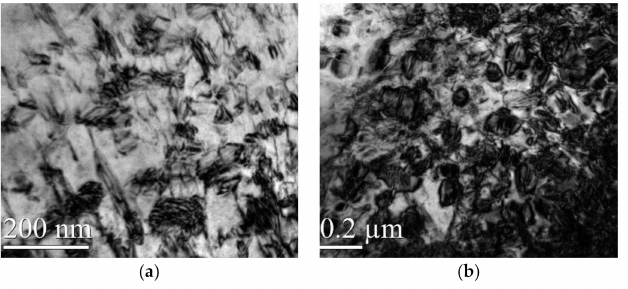
Figure 10. The change of the γ (cid:48)(cid:48) phase shocked by LSP at di ff erent temperatures: ( a ) 25 ◦ C, ( b ) 200 ◦ C.